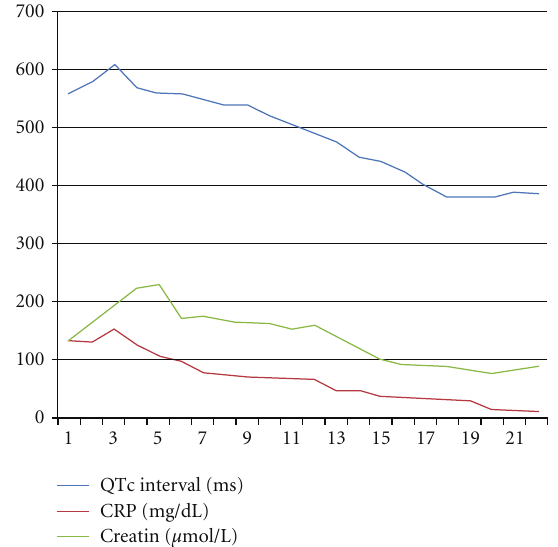
Figure 5: Biological course: CRP: C-reactive protein, Creat: creatinine